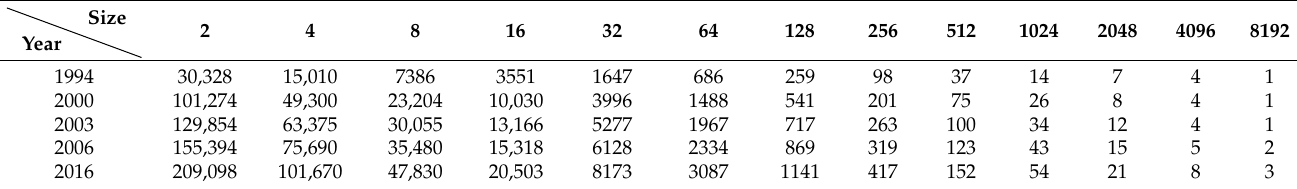
Table 3. Number of boxes in different years and box sizes for urban boundaries.